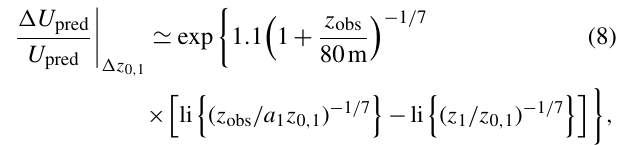
Roughness bias and combined effect of z 0 sensitivities at measurement and prediction